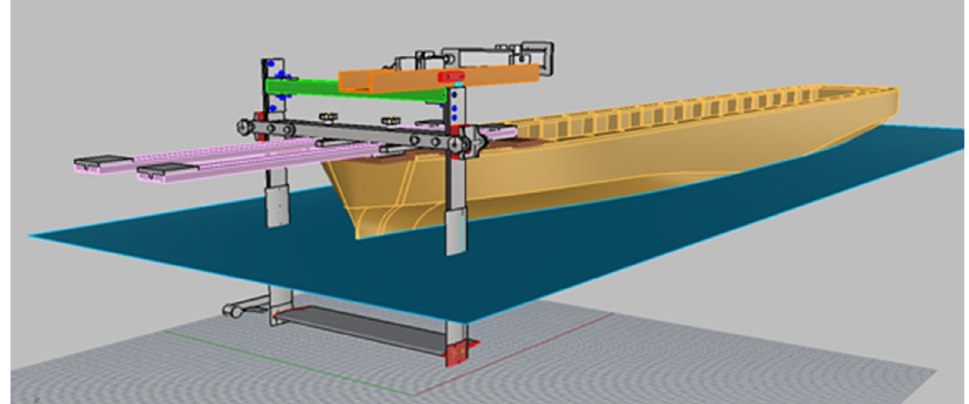
Figure 3. General arrangement of the NTUA tank-scale model with the dynamic wing arranged at the bow.